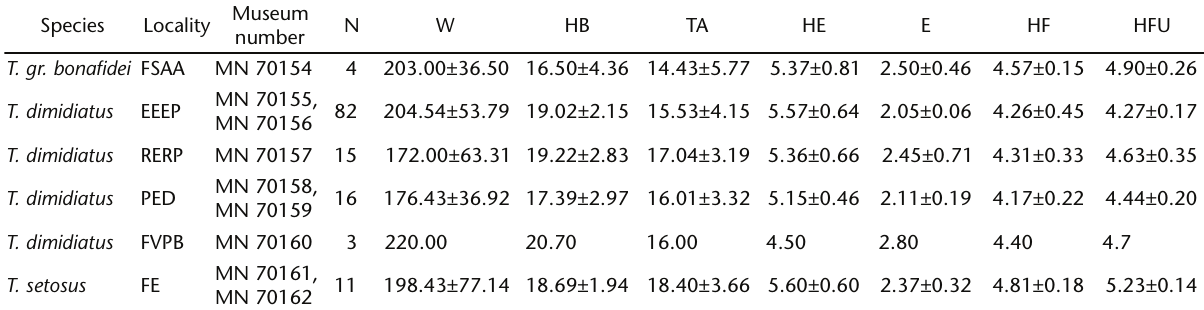
Table I. Specimens of Trinomys captured in the studied areas (Locality), museum number, number of individuals captured (N), mean and standard deviation of body weight (W) and of the measurements: head and body (HB), tail (TA), head (HE), ear (E), hind foot with (HFU) and without nails (HF).